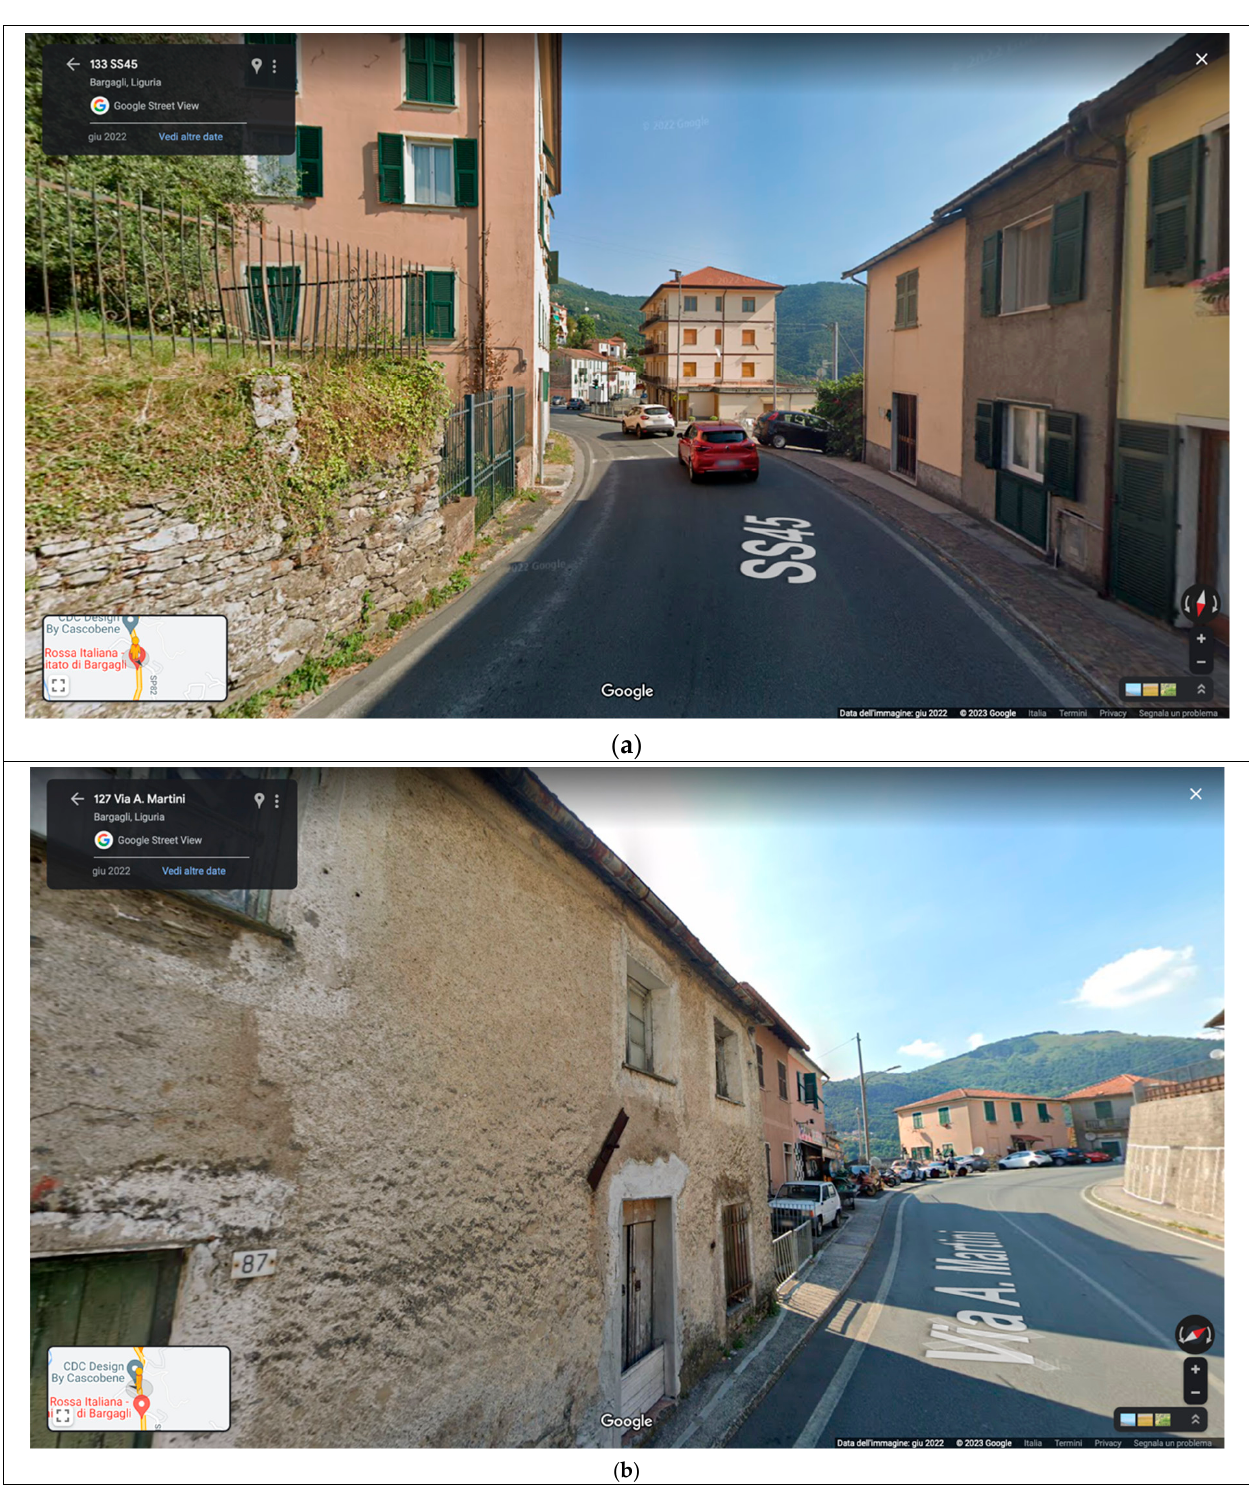
Figure 10. Digital survey of the buildings of Bargagli obtained through Google Maps. ( a ) https://goo.gl/maps/hbfVrNWjekPzviue9 (accessed on 19 January 2023), ( b ) https://goo.gl/maps/uX2 jsMcKdLUr3vuD7 (accessed on 19 January